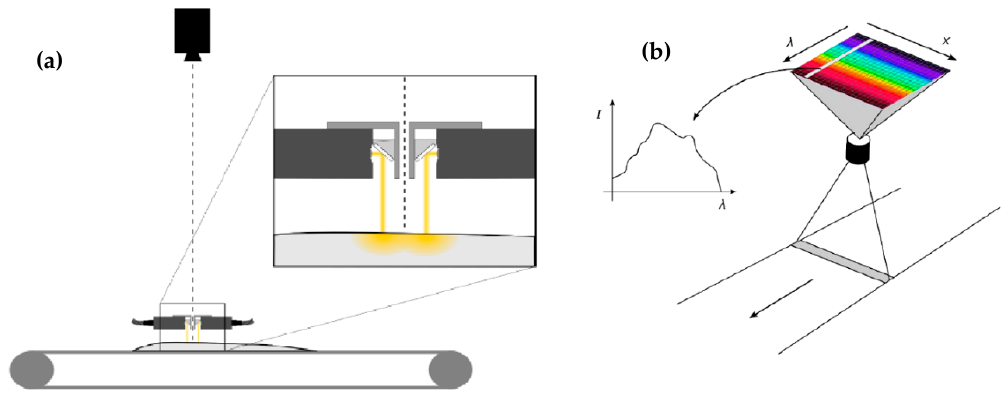
Figure 2. Hyperspectral imaging used for interactance mode. Hyperspectral camera, conveyor belt and fiberoptic line lights used for interactance mode imaging ( a ), and concept of hyperspectral camera, image one spatial line at time with full spectral information ( b ). Adapted from Nofima’s report 28 / 2017: Automatic quality control of internal defects in cod—results from hyperspectral, ultrasound, and X-ray imaging.